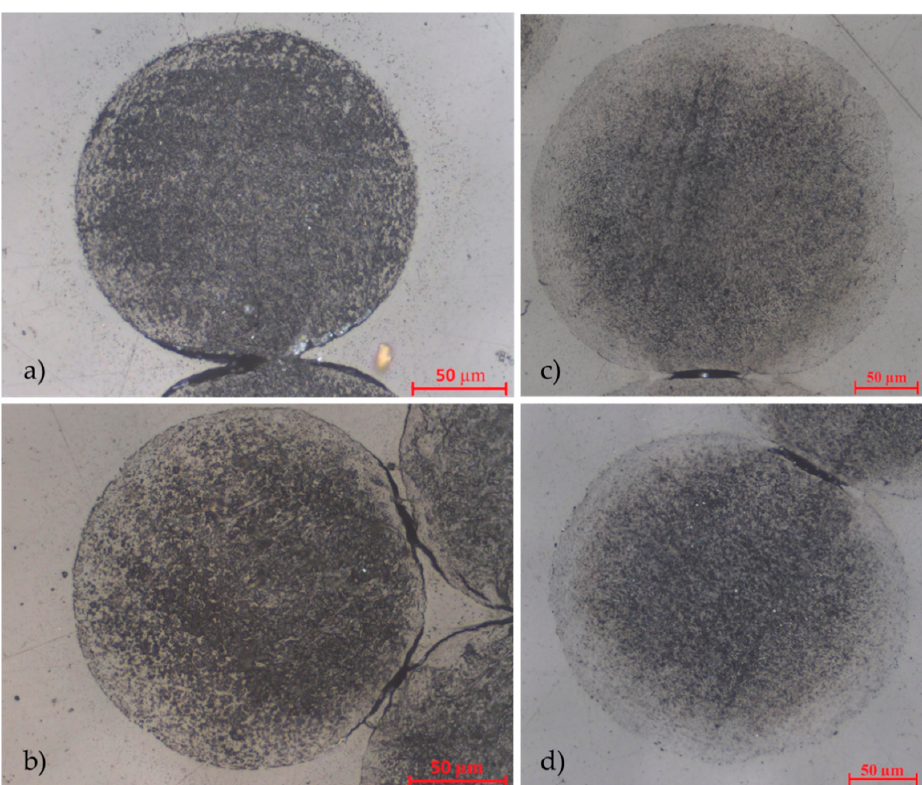
Figure 4. Cross-section of monocomponent filaments consisting of thermoplastic polyurethane (TPU) + CNT: ( a ) CNT content: 2 wt.%, spinning speed: 37.2 m/min; ( b ) CNT content: 4 wt.%, spinning speed: 30 m/min; ( c ) CNT content: 6 wt.%, spinning speed: 10 m/min; ( d ) CNT content: 6 wt.%, spinning speed: 17 m/min.